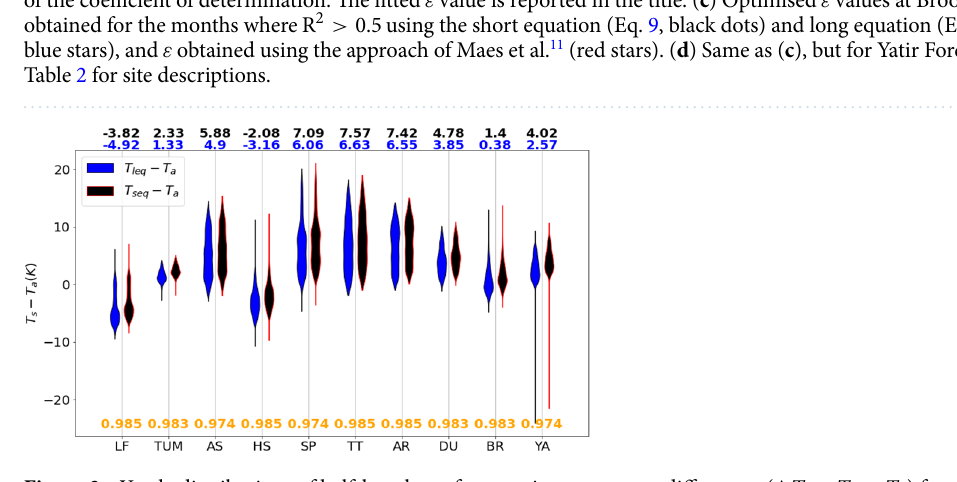
values of daytime (cid:31) T are negative. Comparison of plot-scale LST estimated using ε MODIS at satellite overpass time with landscape-scale LST ( T MODIS ) revealed strong correlations at most of study sites but systematically lower plot-scale LST (Fig. 3a, b). Use of ε plot for LST estimation ( T seq and T leq ) resulted in substantial reduction of the bias as shown in Fig. 3c, d. This trend in bias reduction was similar at other sites (SI Table 2 for details). The minimum bias is found at TUM, a closed canopy (eucalyptus forest) and the highest bias was obtained at